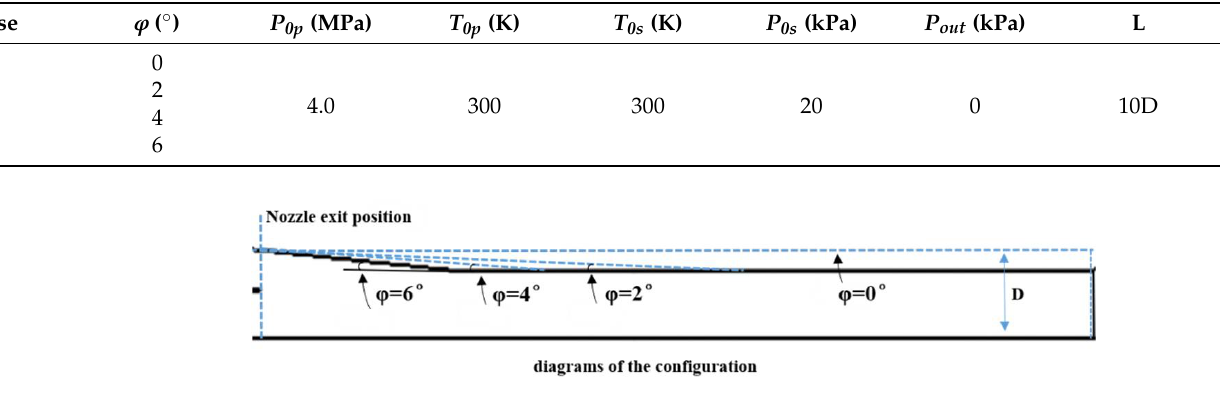
Figure 1. Schematic diagram of ejector configuration. Table 1. Boundary condition parameters.